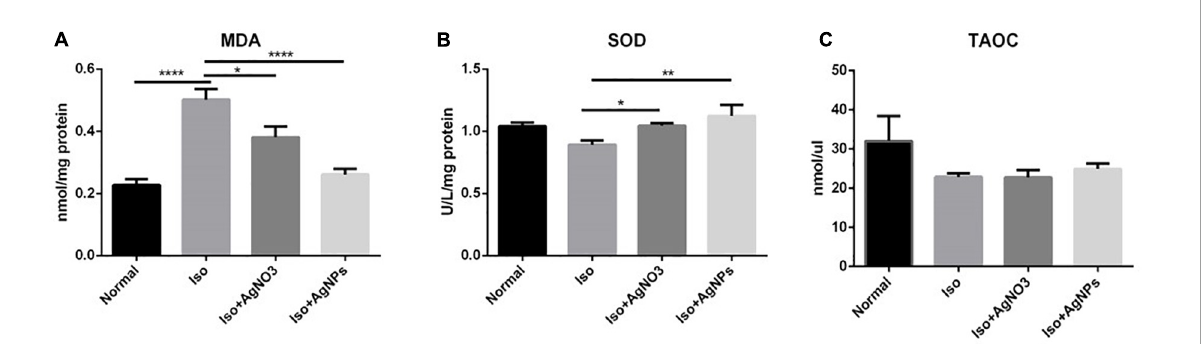
FIGURE6 The effects of AgNO 3 and AgNPs on the level of MDA in cardiac tissue (A) , SOD activity in cardiac tissue (B) , and the TAOC level (C) in serum. Each column represents the mean ± SEM of six rats. Data analysis was performed using one-way ANOVA, followed by Tukey multiple comparison test. **** P < 0.0001; ** P < 0.01; * P < 0.05. Iso, isoproterenol; AgNO 3 , silver ion; AgNPs, silver nanoparticles.